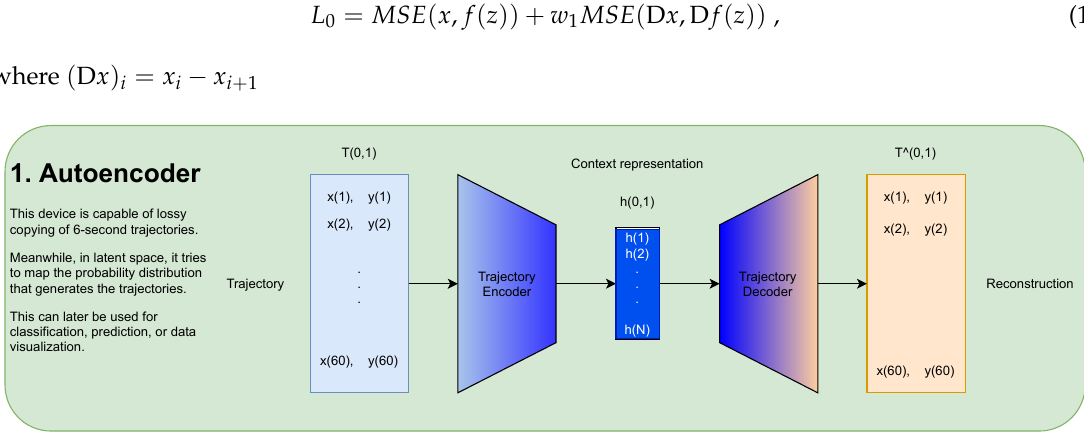
Figure 3. Concept of the autoencoding scheme to learn latent features from the distribution of trajectories. The encoder and decoder are enforced to copy the data with the reconstruction loss as low as possible with an informational